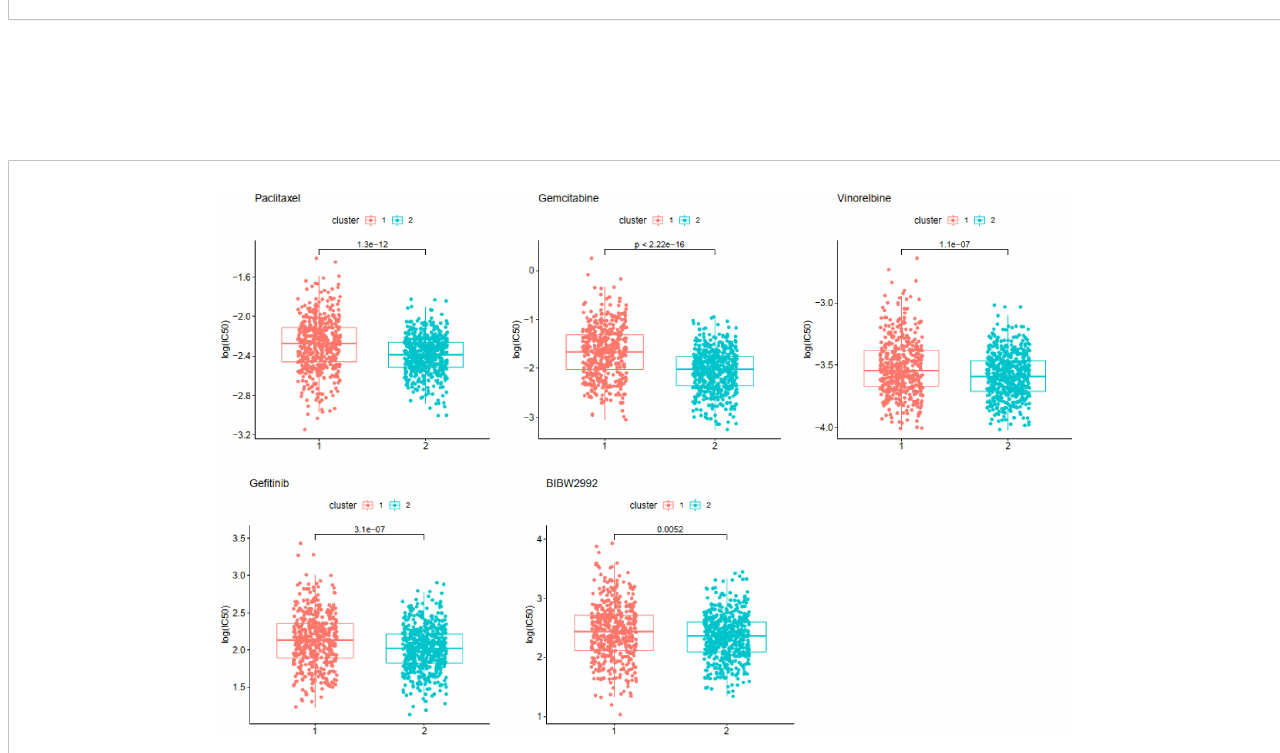
FIGURE 8 Drugs sensitive in cluster1.